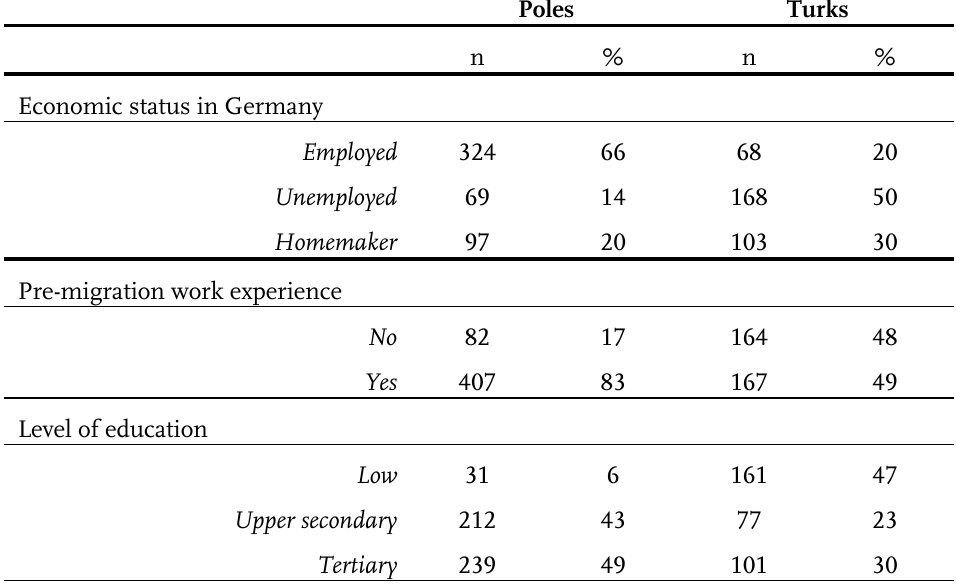
Table 1 : Descriptive statistics of recently-arrived female migrants (column percent) Poles Turks n % n